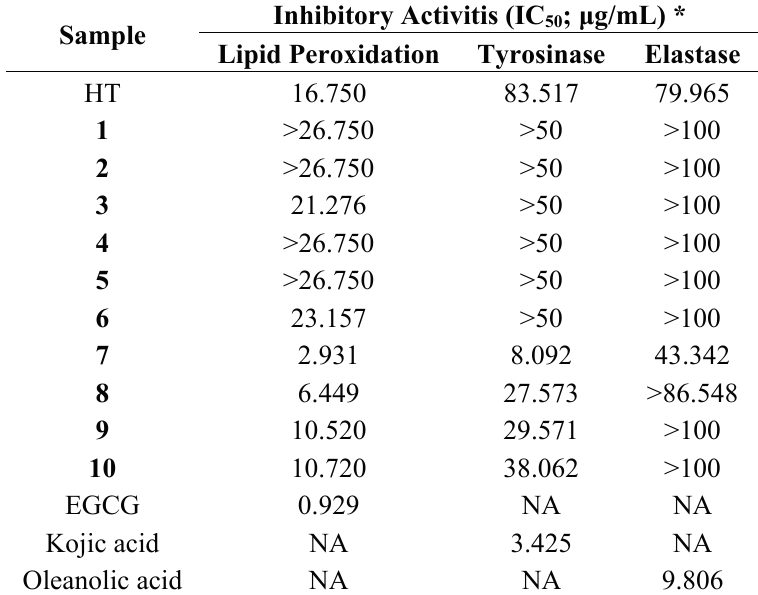
Table 3. The effects of H. teretifolium constituents on inhibition of Fe (II)-induced microsomal lipid peroxidation, tyrosinase and elastase